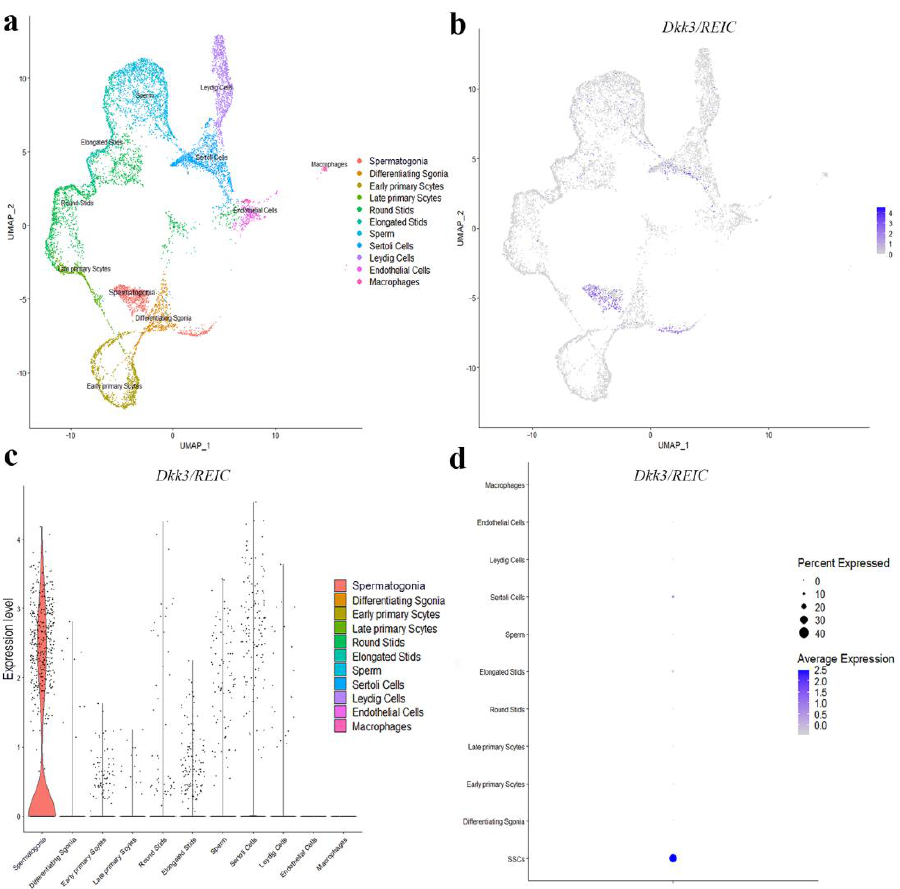
Figure 2. Distribution of Dkk3/REIC among testicular cell clusters in public scRNA-seq transcriptome atlas. ( a ) Analysis revealed 11 clusters that were matched to 11 testicular cell types. ( b ) The FeaturePlot function, ( c ) VlnPlot function and ( d ) DotPlot function of Seurat packages demonstrated the distribution of Dkk3/REIC among these different cell types. The results indicated that Dkk3/REIC had the highest level in spermatogonia.